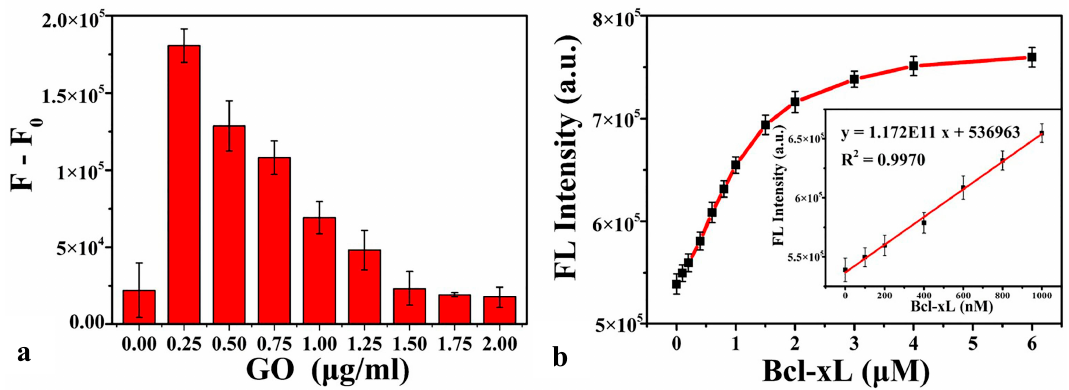
Figure 6. The peptide-GO sensor tested in 2% serum assay. ( a ) The Fluorescence intensity changes of peptide-GO sensor in the presence (F) and in the absence (F 0 ) of 5 μ M Bcl-xL with the increasing amount of GO from 0 to 2 μ g/mL in the 2% serum; ( b ) Fluorescence intensity of TAM-PEP (R8) as the increasing concentrations of Bcl-xL; the inset was the linear relationship between fluorescence intensity and Bcl-xL concentrations in 2% serum assay. Experiment conditions: TAM-PEP (R8) 100 nM; Incubation time: 1 h; Room temperature. Excitation: 540 nm.